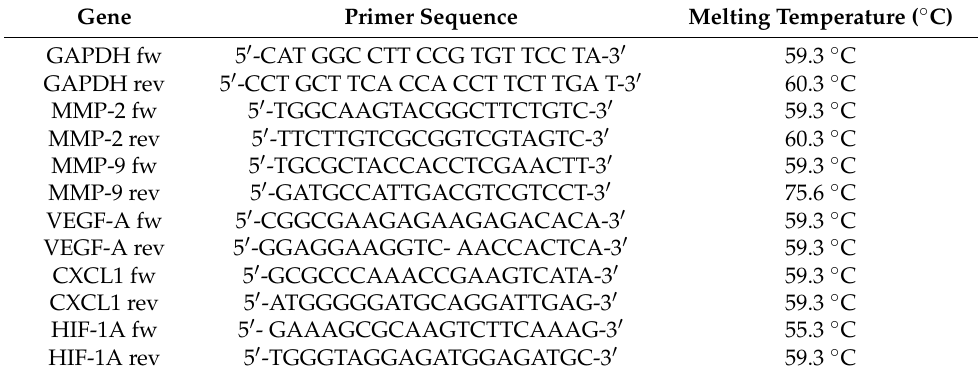
Table 1. Primers’ sequence and melting temperature melting of primers used in q-RT-PCR.